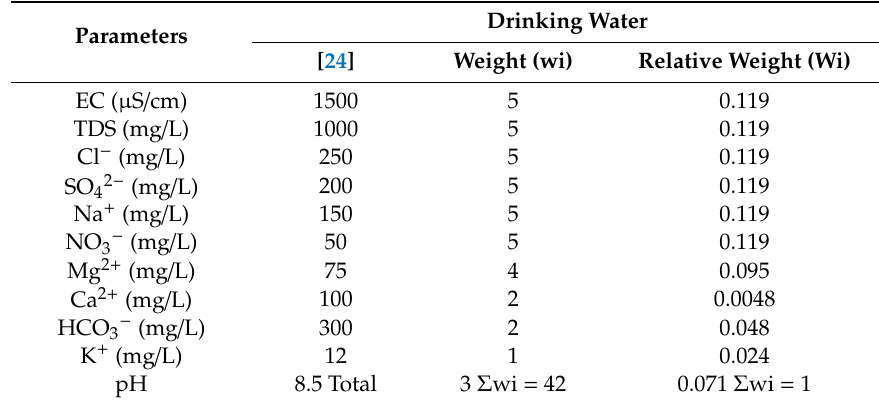
Table 3. The weight (wi) and relative weight (Wi) for each applied parameter. EC: electrical conductivity. Drinking Water Parameters